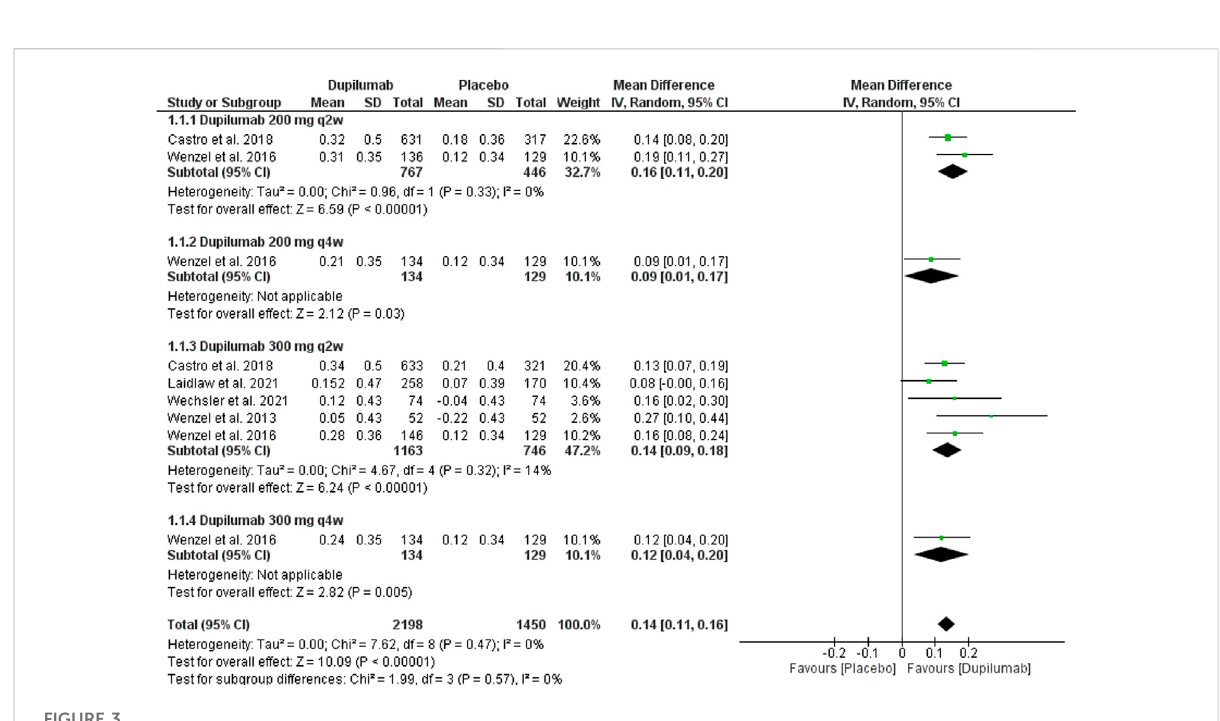
FIGURE 3 Results of the FEV1 change at the 12th